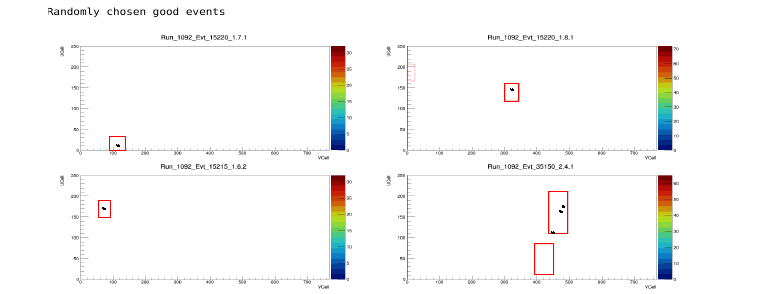
Figure 9. The matching of RoI and PXD hits. The reconstructed RoI boxes are shown with the hits in PXD for four randomly selected